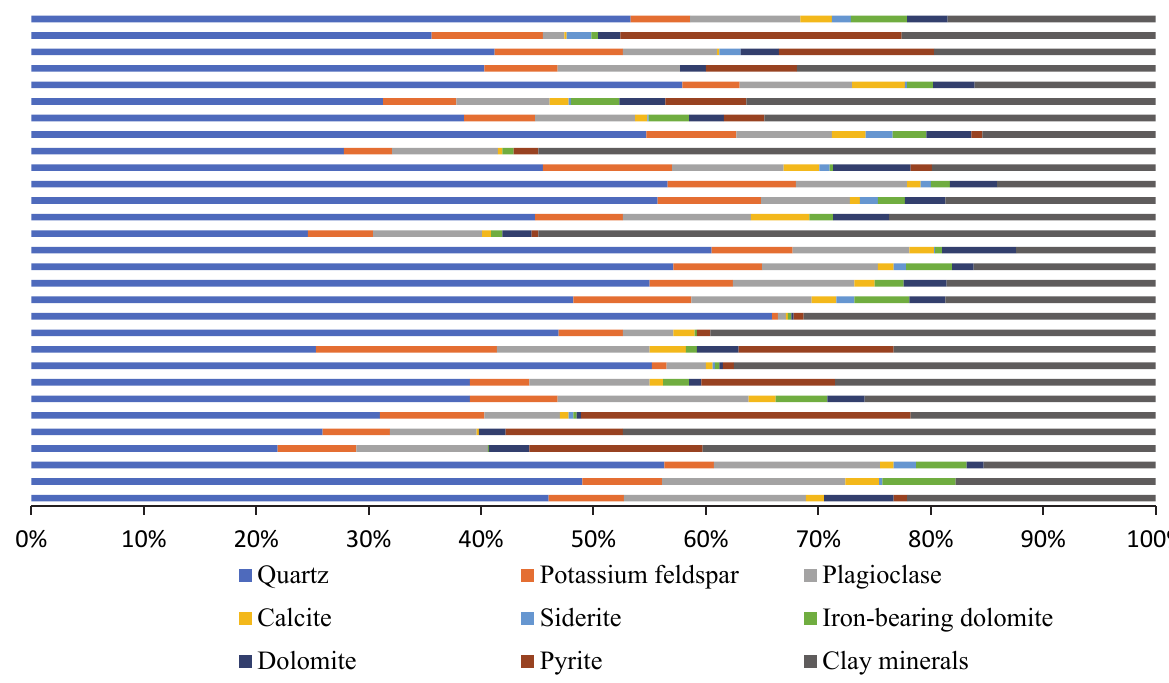
Figure 4. XRD mineral content percentage diagram of 30 rock samples in the study area.